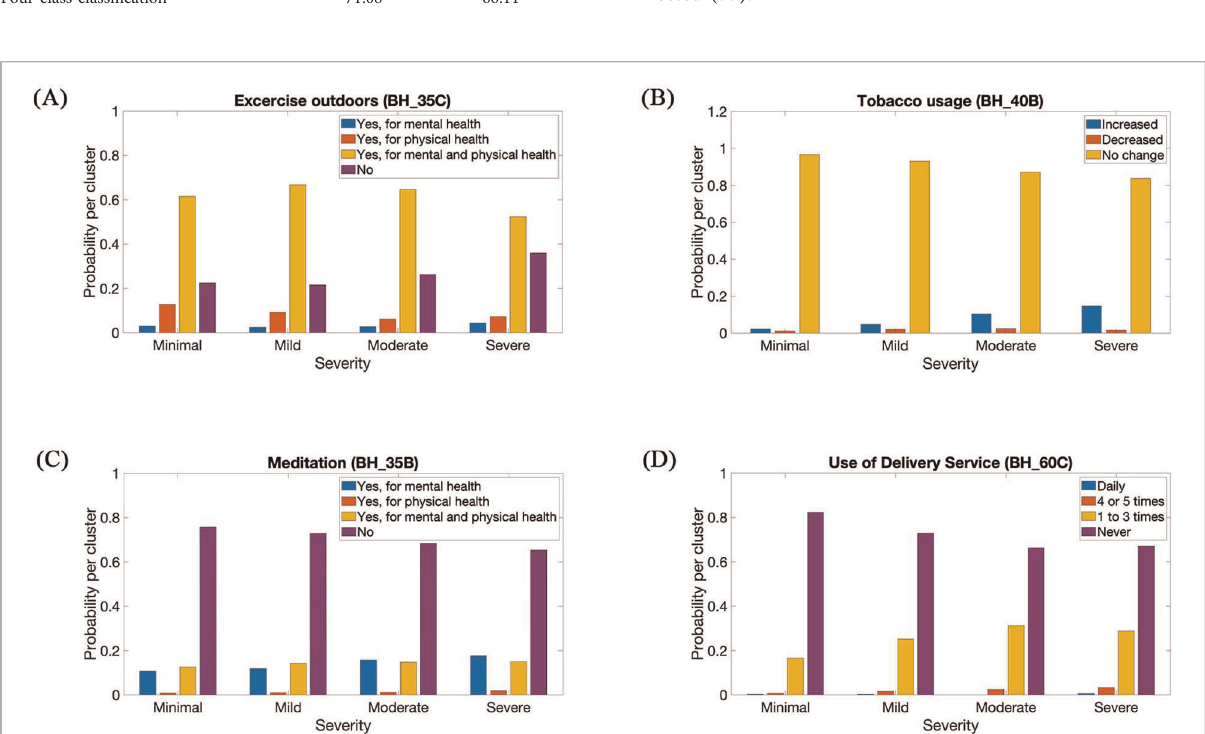
FIGURE 4 Probability distribution of ( A ) exercises outdoors, ( B ) tobacco usage, ( C ) meditation, and ( D ) use of delivery services, in respect to